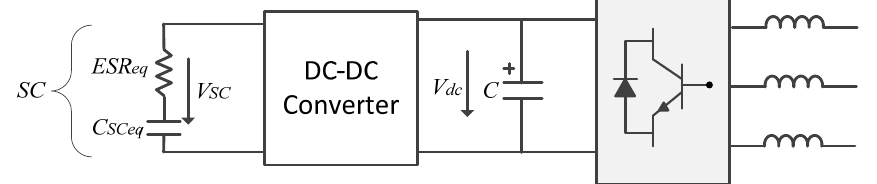
Figure 12. STATCOM + ES (energy storage) with a DC-DC converter. SC,